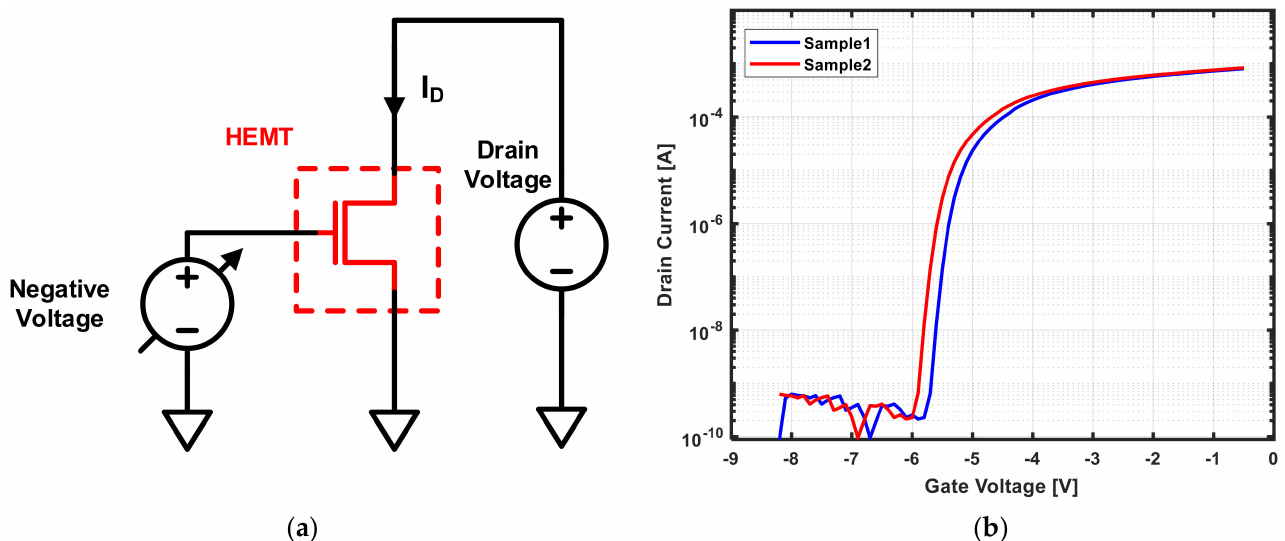
Figure 3. ( a ) HEMT device diagram; ( b ) HEMT device I-V